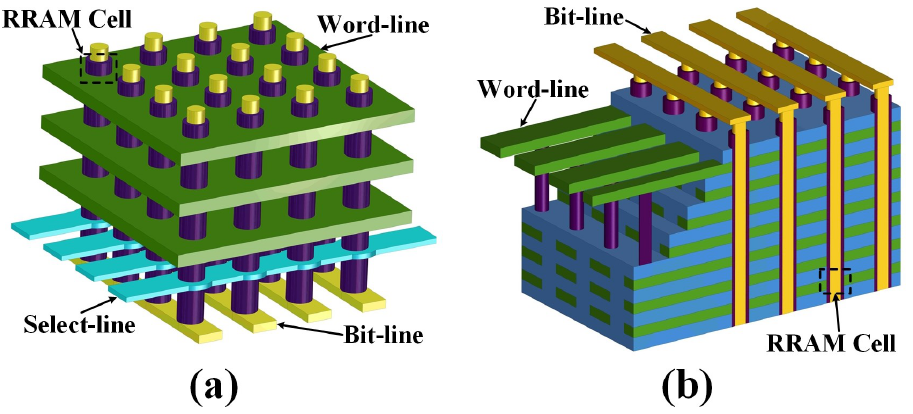
Figure 1. ( a ) Schematic of traditional 3-D VRRAM and ( b ) schematic of HfO 2 /TaO x -based on a built-in nonlinear 3-D